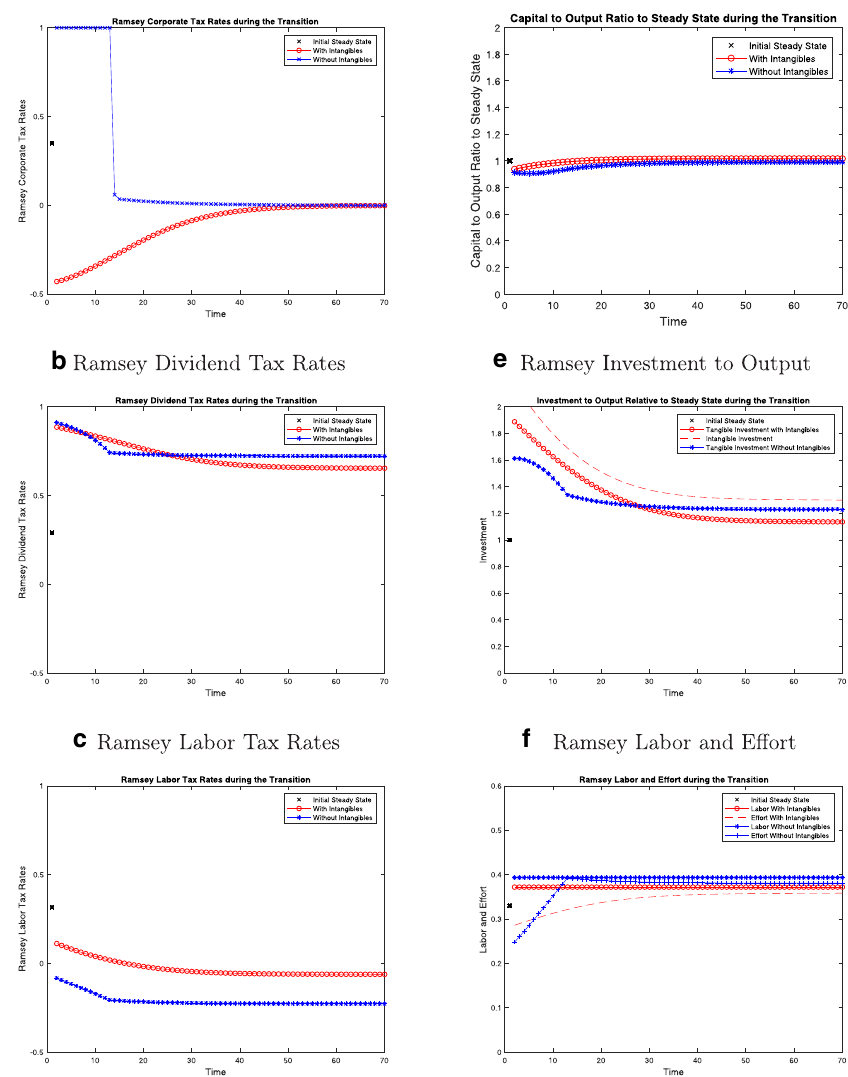
Fig. 8 Ramsey taxes and allocation for γ 1 = 0 . 75 and γ 2 = 0 .